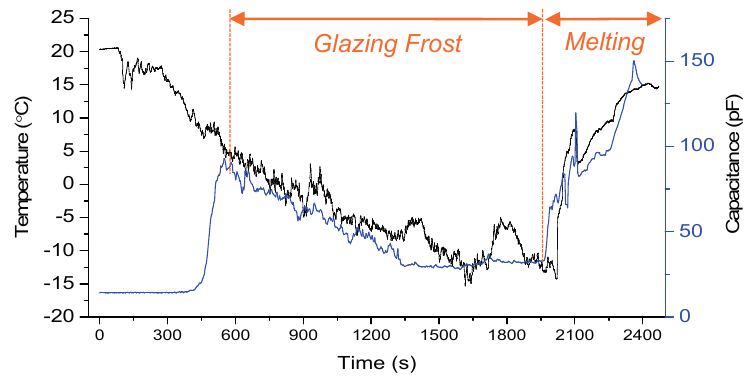
Figure 9. Real time measurement of ice formation cycle.